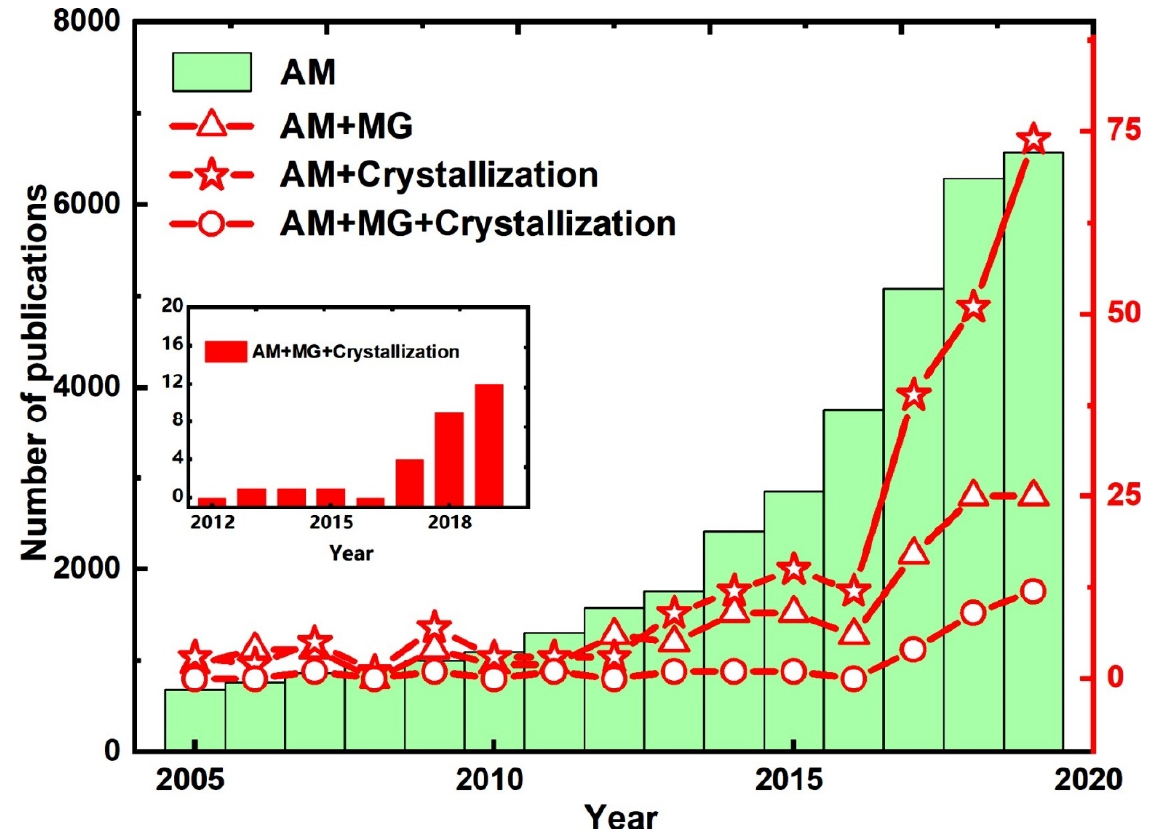
Figure 3. Number of publications related to AM, MG and/or crystallization from 2005 to 2019. Reproduced from [18], with permission from Elsevier, 2021.